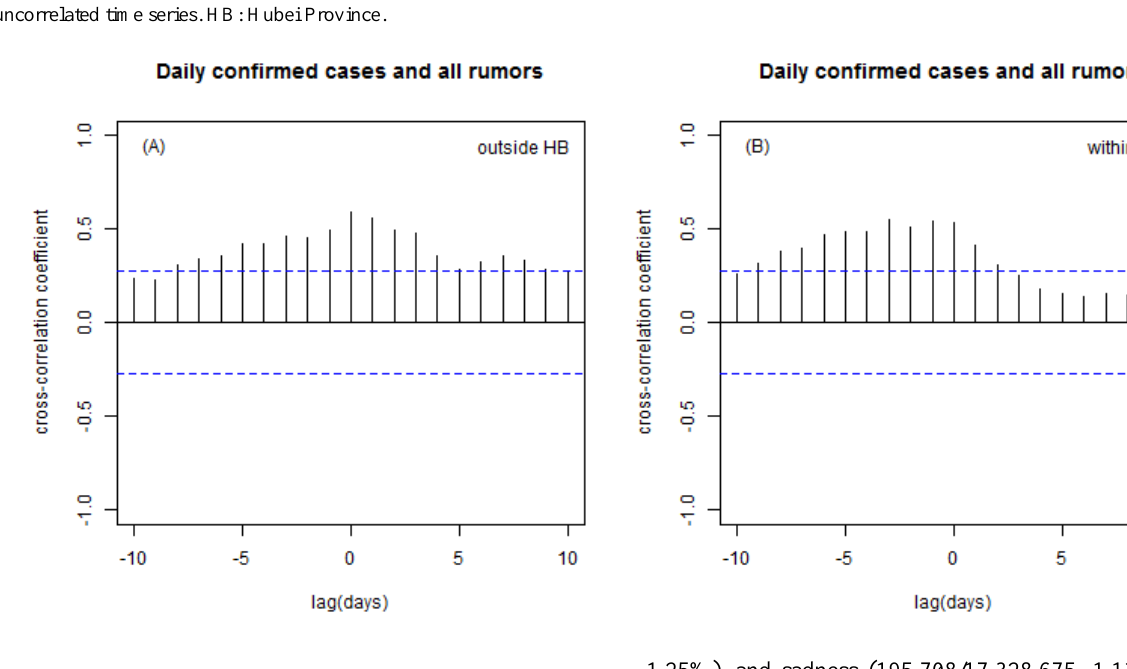
Figure 2. (A) Cross-correlation between the daily number of newly confirmed cases outside Hubei Province and all rumors. (B) Cross-correlation between the daily number of newly confirmed cases in Hubei Province and all rumors. Blue dashed lines denote the 95% confidence intervals of the uncorrelated time series. HB: Hubei